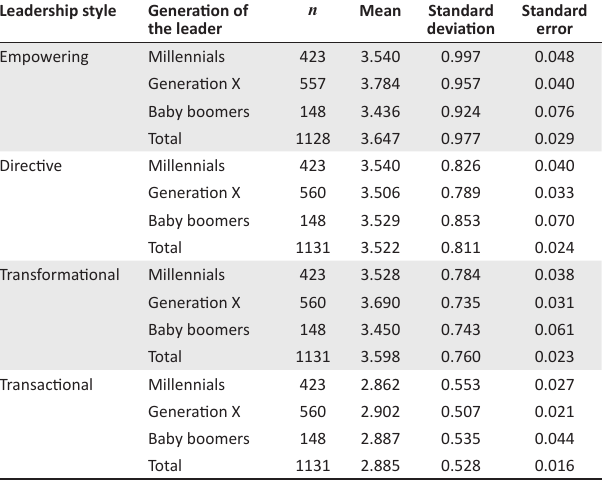
TABLE 5: Mean scores per leadership style and generation. Leadership